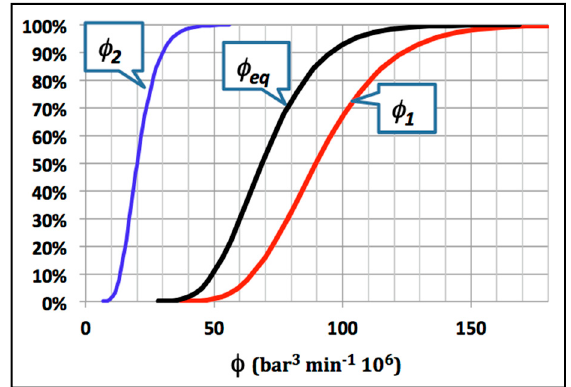
Figure 3. Statistical distribution of damage factors.